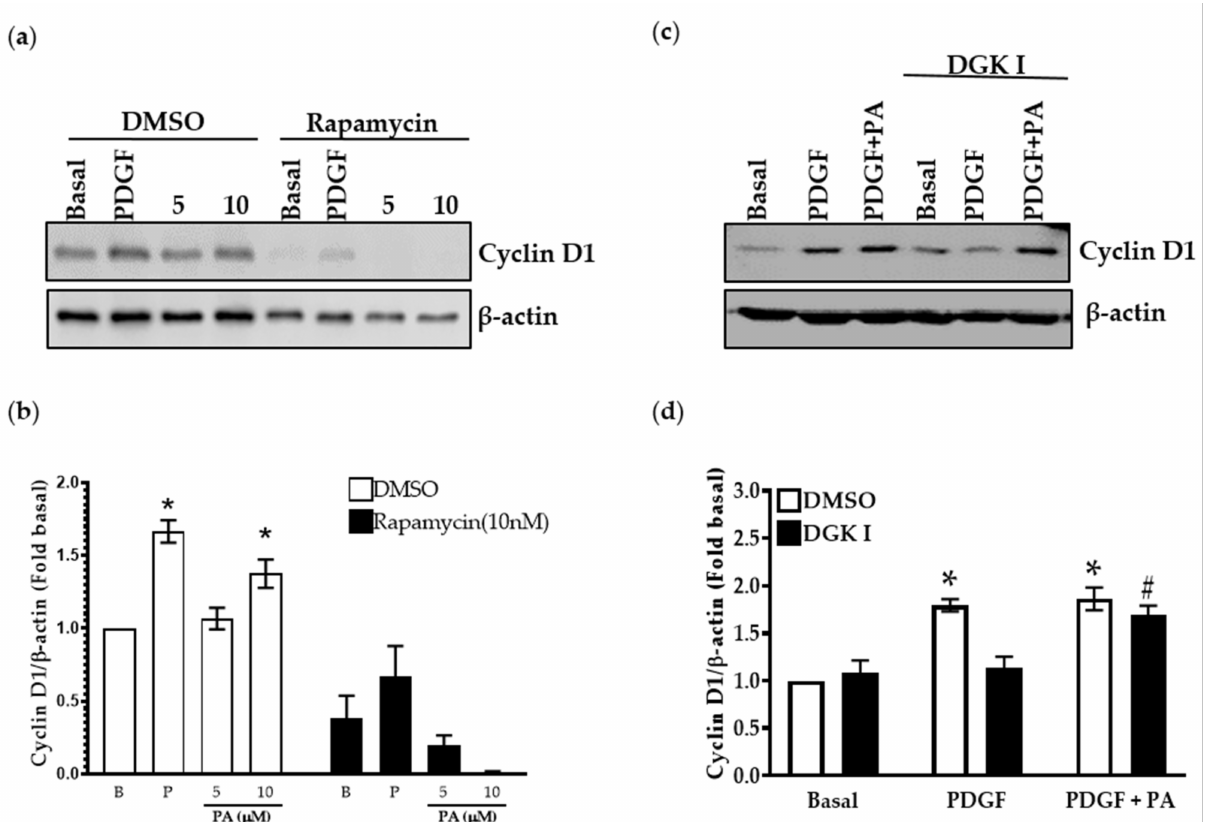
Figure 8. Effect of DGK and rapamycin inhibition on cyclin D1 expression. ( a , b ) Human ASM cells were pretreated with rapamycin (10 nM) for 10 min, followed by stimulation of PA (5 µ M or 10 µ M) for 24 h, lysed, and immunoblotted for cyclin D1; ( c , d ) Human ASM cells were pretreated with DGKI (30 µ M) followed by stimulation with PDGF (10 ng/mL), or PDGF (10 ng/mL) with PA (10 µ M) for 24 h, lysed and immunoblotted for cyclin D1. Graphical representations of densitometry data from blots are normalized to basal conditions. Data above are mean ± SEM from n = 4–7 independent donors. * p < 0.05 compared to basal, # p < 0.05 DGKI (PDGF vs. PDGF + PA) using one-way ANOVA with Bonferroni post-hoc analysis. PA: Phosphatidic